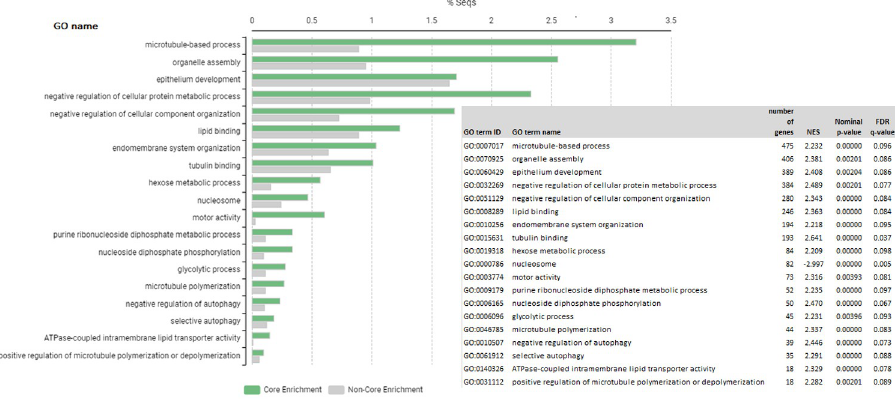
Fig 2. Gene Set Enrichment Analysis (GSEA) bar chart for all the genes detected in sperm samples. Top Go terms by the Normalized Enrichment Score (NES) for an FDR < 0.1.FDR = False discovery rate. % Seqs = percentage of sequences in each GO